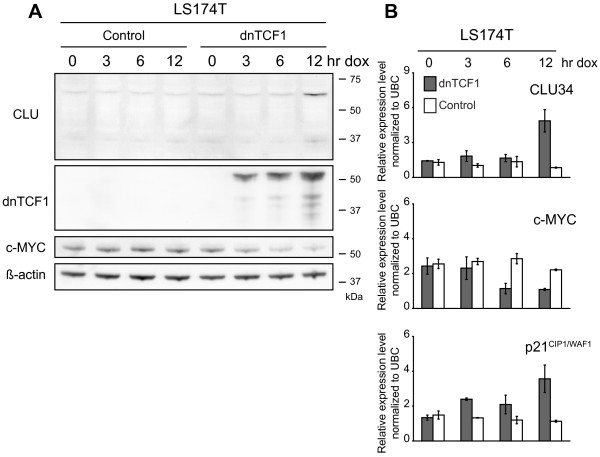
Expression kinetics of CLU mRNA and protein levels after induction of dnTCF1 in LS174T cells. Expression kinetics of CLU mRNA and protein levels were studied 0, 3, 6, and 12 hr after induction of dnTCF1 in LS714T cells. c-MYC and p21CIP1/WAF1 mRNA levels were also monitored. (A) Western blot with cell lysates from LS174T cells 0, 3, 6, and 12 hr after induction. CLU protein levels do not increase until 12 hr after induction. Exogenous dnTCF1 proteins are induced as early as 3 hr after induction, and c-MYC protein levels decrease in parallel. (B) Real time RT-PCR shows that CLU34 and p21CIP1/WAF1 mRNA levels do not increase until 12 hr after induction. c-MYC mRNA levels decrease 6 hr after induction. Data are presented as the mean ± standard deviation from 2 separate experiments with each experiment consisting of the mean value of 3 independent determinations.